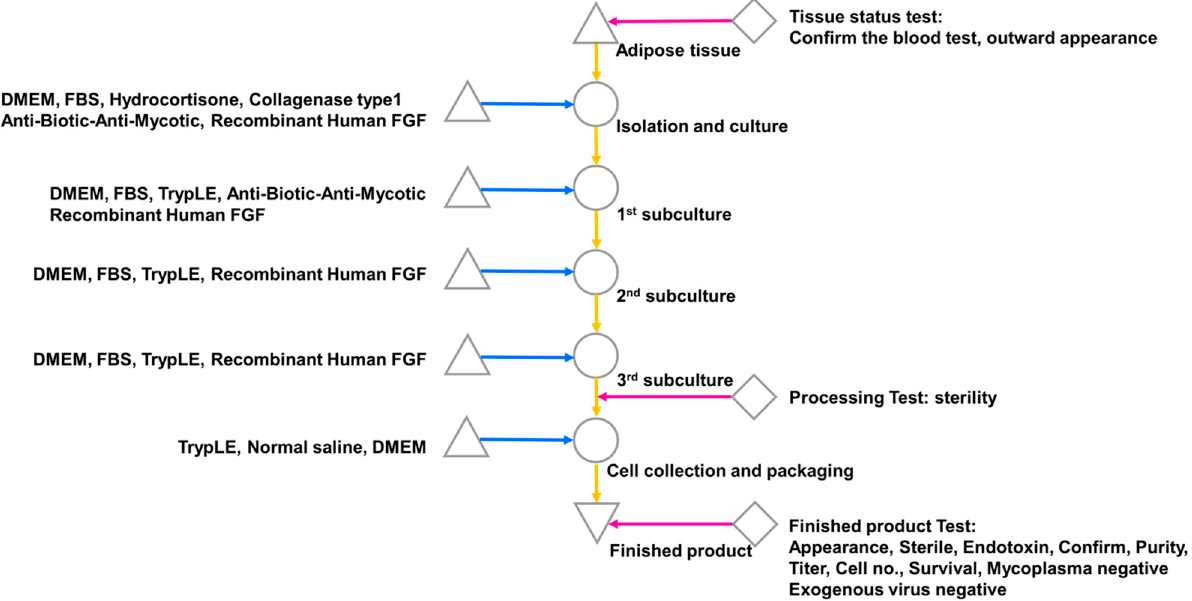
Figure 1. ADSC isolation from human-derived adipose tissue. Single cells were isolated from adipose tissue and subcultured three times with FGF; cells were collected after the third subculture and subjected to a product suitability test.